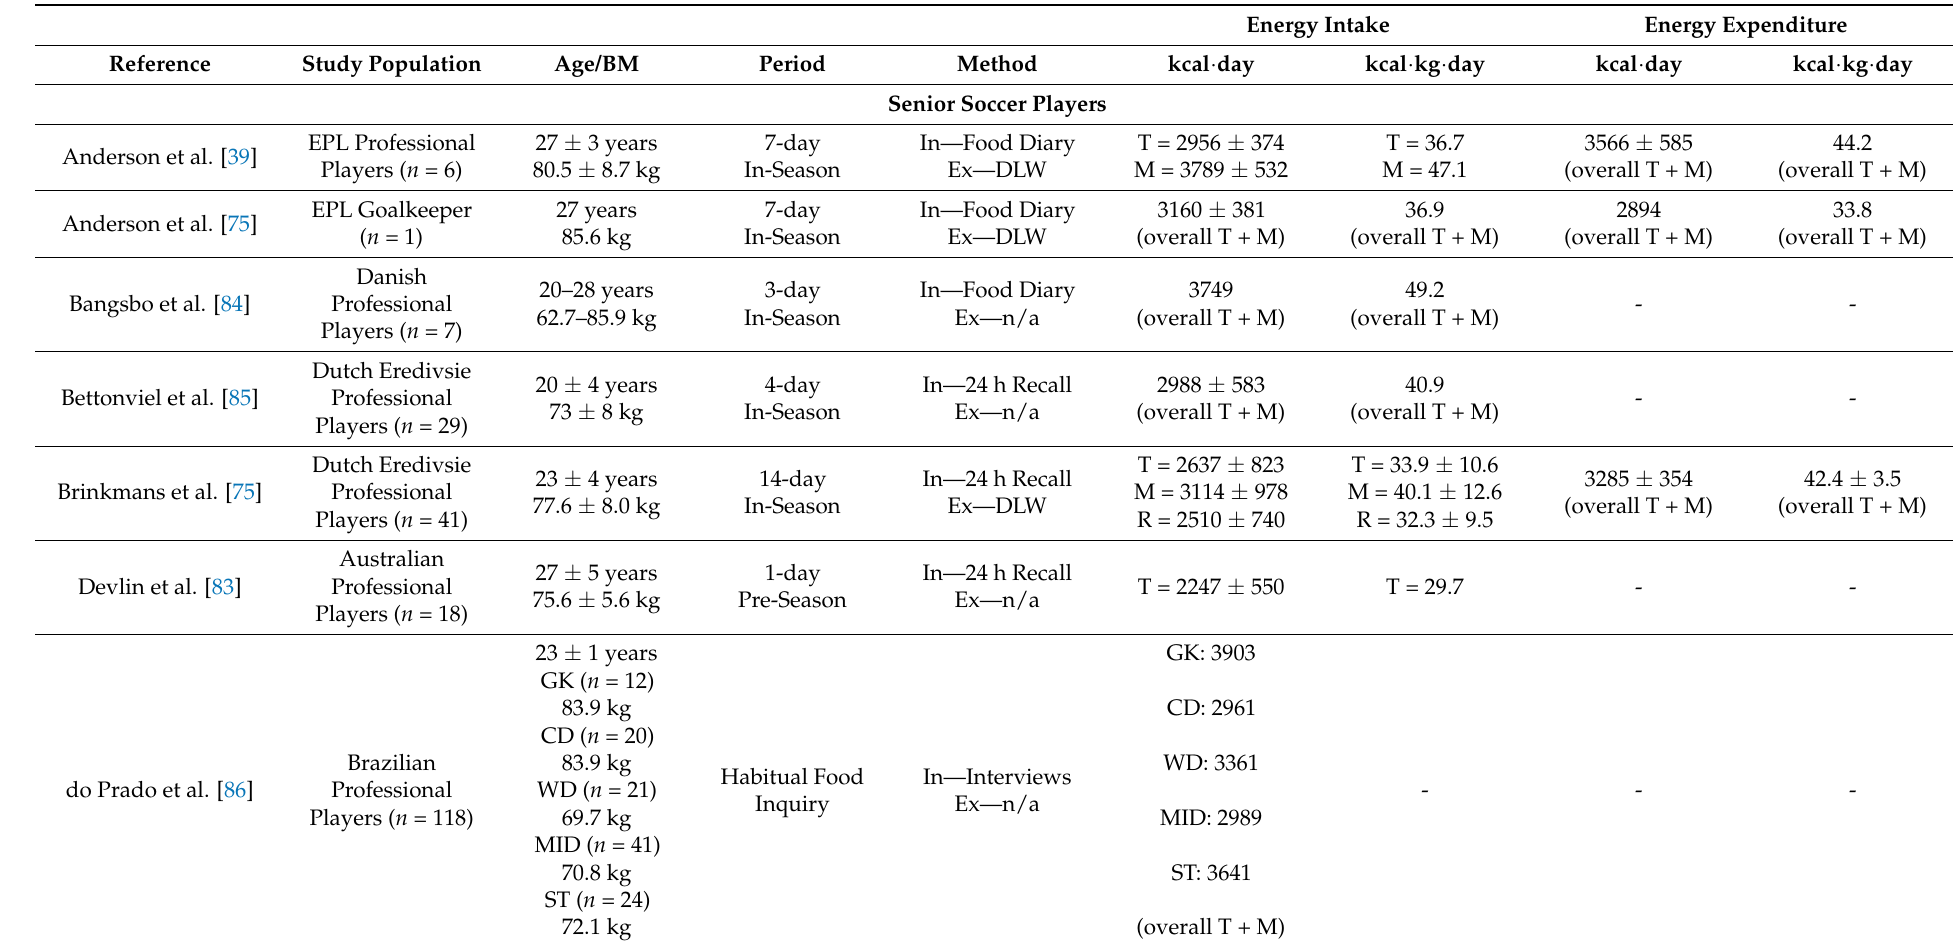
Table 1. Energy intake and expenditure of male soccer players during training and match